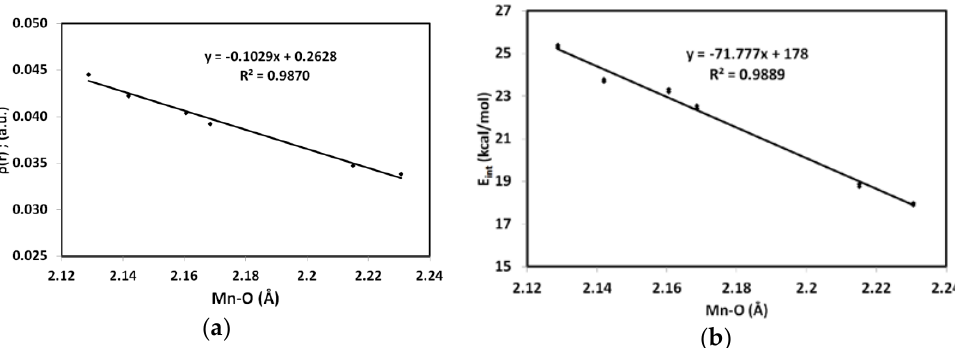
Figure 7. Correlation between ρ(r) ; ( a ) and interaction energies (E int ); ( b ) with Mn–O distances.